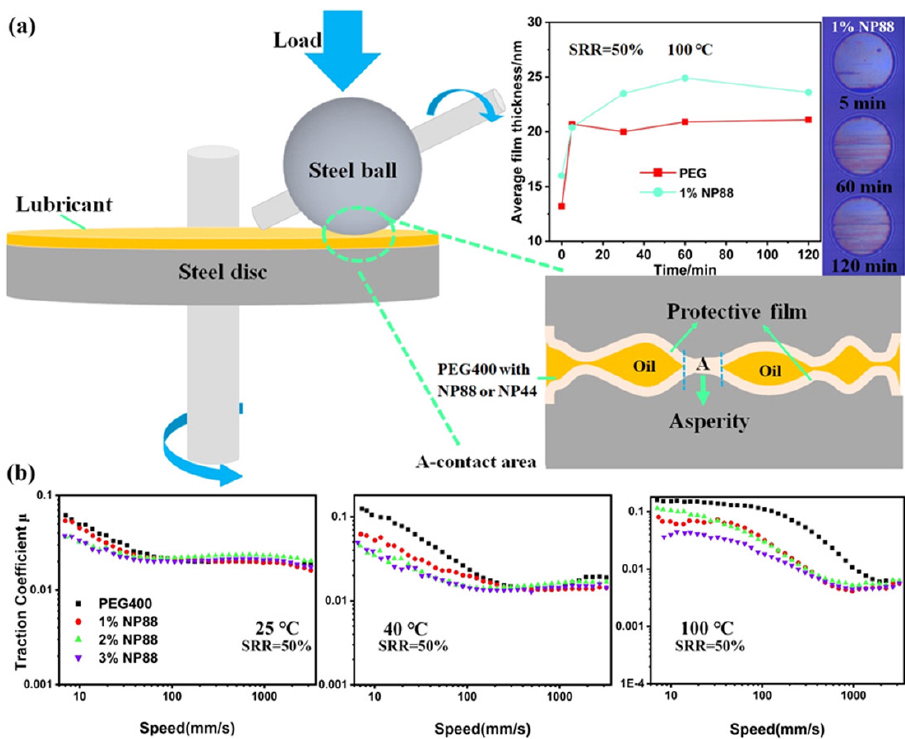
Fig. 9 (a) Schematic of the proposed mixed lubrication mechanism of polyethylene glycol (PEG)400 with NP44 or NP88 and the variation of average film thickness with rubbing time under the lubrication of PEG400 and 1% NP88 at Ս е of 50 mm/s, load of 20 N, slide-to-roll ratios (SRR) of 50% and temperature of 100 °C. (b) Stribeck curves of PEG400 and PEG400 with different concentrations of the NP88 at temperatures of 25, 40, and 100 °C, SRRs of 50%, and load of 20 N [137]. Reproduced with permission from Ref. [137], © Elsevier Ltd.,